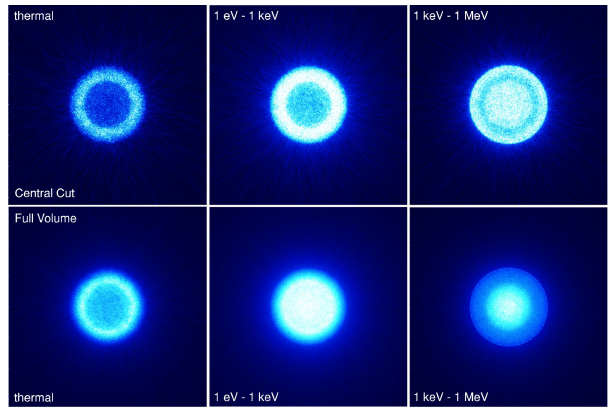
Figure 12. Flux calculation of Bonner spheres of 2in. diameter. The simulated neutron tracks ( E kin = 10keV) of 10 6 histories are displayed in a central cross section of 3mm height (top row) and the full domain of 13cm × 13cm × 5.4cm (bottom